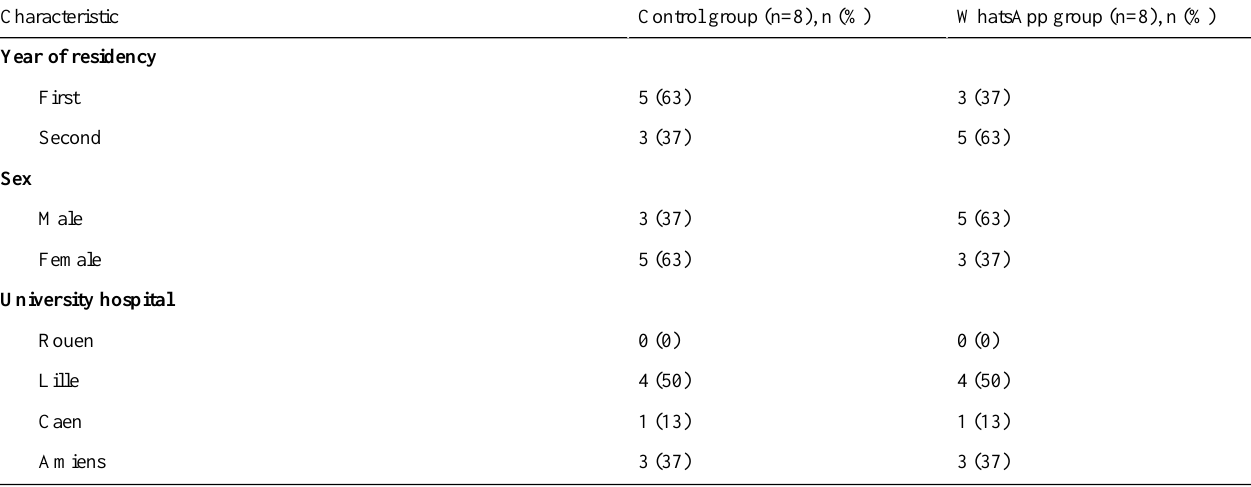
Table 4. Demographic characteristics of residents who did not answer the final